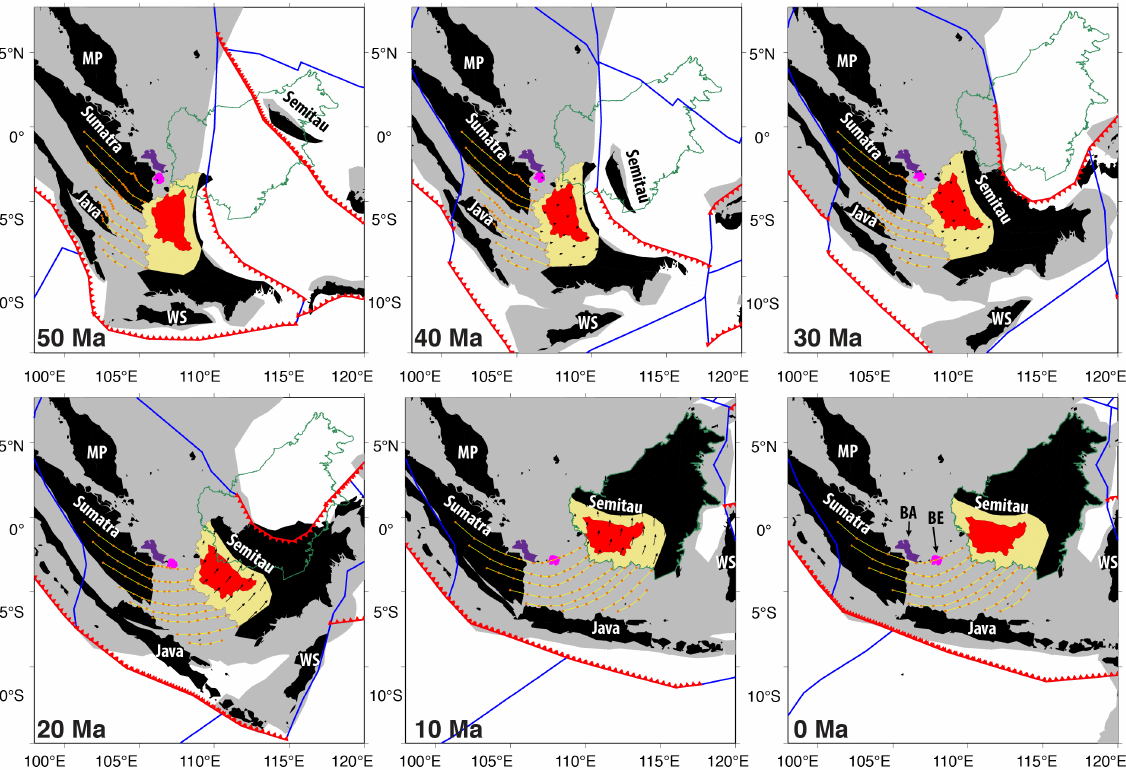
Fig. 7. The curved lineaments on the Sunda Shelf have been proposed by Hutchison (2010) to represent evidence of oroclinal bending of the continental promontory. We digitize these curvatures from the vertical gravity gradient (Fig. 4) and use the lineaments to derive an oroclinal bending model for Sundaland. We partition the counterclockwise rotation of Borneo from 50 to 10Ma following evidence of rifting in the Java Sea, and partition 50 ◦ CCW rotation of Borneo from 25 to 10Ma following the paleomagnetic constraints provided by Fuller et al. (1999). Not only does the oroclinal bending model restore the generally north–south strike of the east Asian active margin in the Cretaceous, it can also be used to restore the position of Belitung (Billiton) Island to be adjacent to Bangka Island, and hence restoring the Mid- to Late Triassic volcanic arc related to the Southeast Asian tin belt. Plate boundaries (MORs/transforms–blue, subduction zones–red) are plotted in a Sumatra-fixed reference frame. The Borneo core (yellow) is largely comprised of the Schwaner Mountains and related granitoids (red), which is used to sample the velocity field of Borneo’s motion relative to Sundaland. The positions of Borneo from Lee and Lawver (1995) are shown for comparison (green outline). See Supplement B for detailed steps for deriving the oroclinal bending model for Sundaland. BA–Bangka Island (violet), BE–Belitung (Billiton) Island (magenta), MP–Malay Peninsula, WS–West